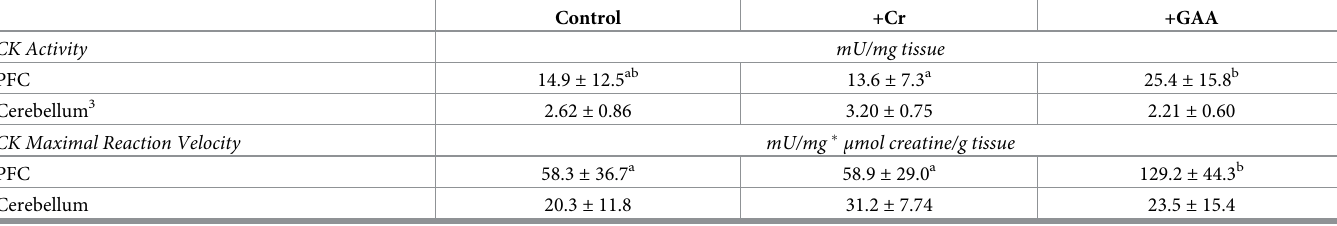
Table 3. Creatine kinase (CK) activity and maximal reaction velocity in brain regions of pigs supplemented with GAA (+GAA) or creatine (+Cr) relative to unsup- plemented Control. 1,2